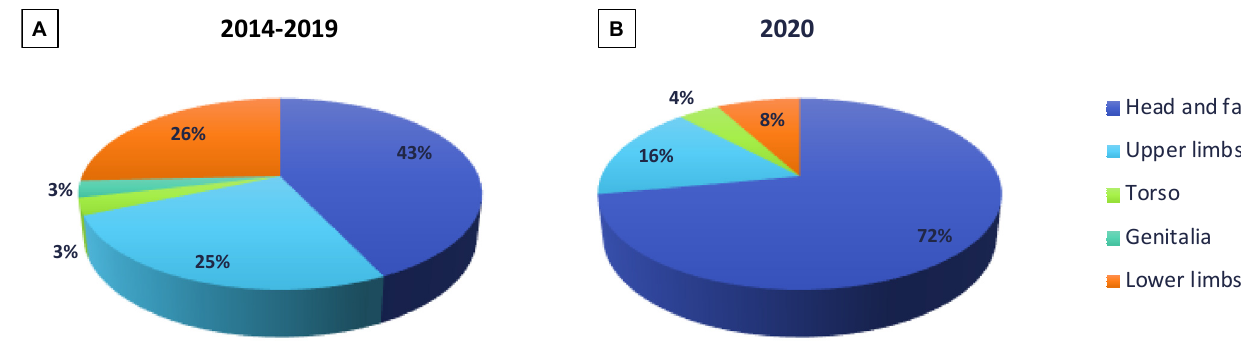
Figure 1. Anatomical distribution of the sites of bites during the 2014–2019 period ( A ) and 2020 ( B ).